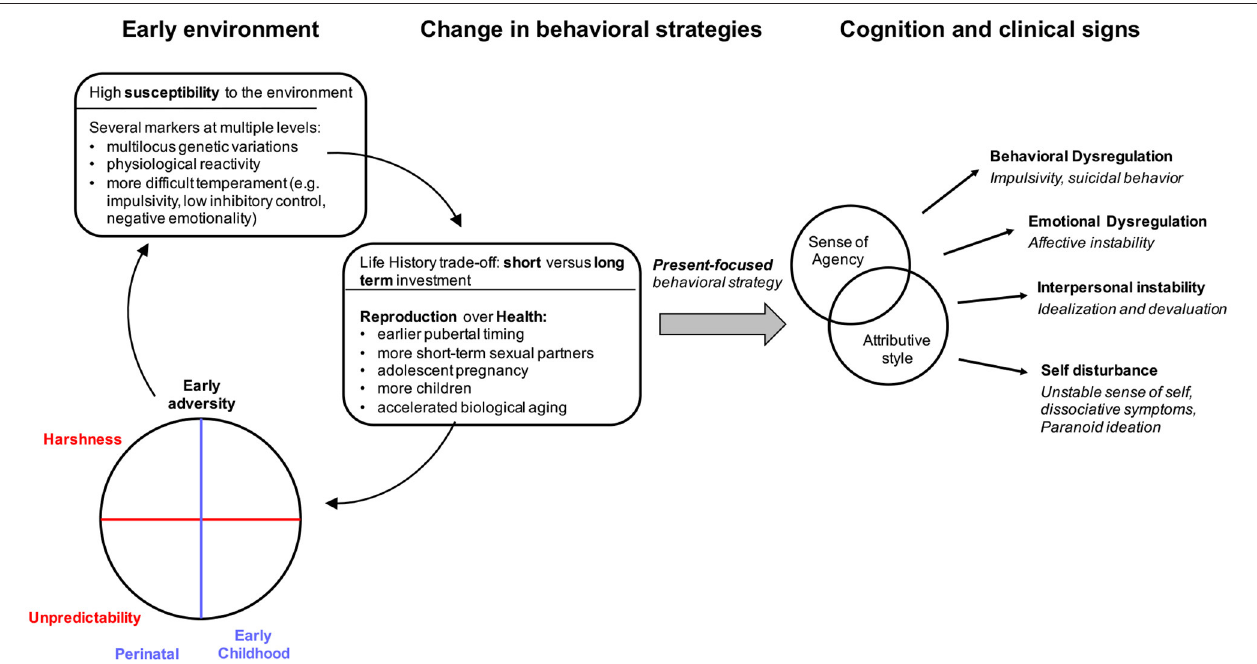
FIGURE 3 | Putative developmental processes mediating the association between early environmental adversity and BPD